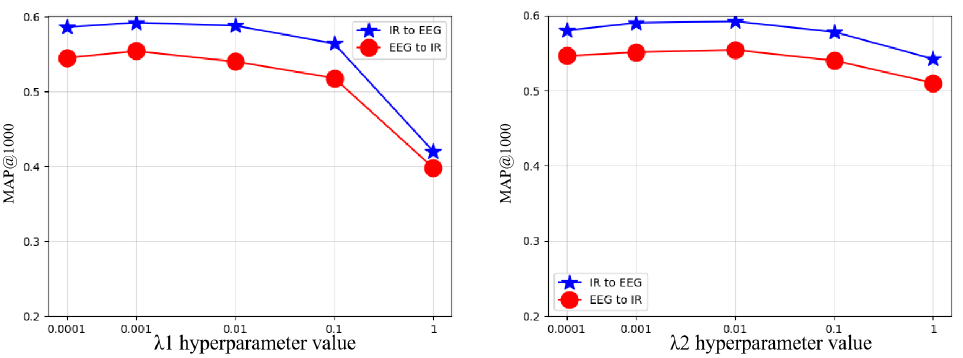
Figure 4. Sensitivity analysis of the proposed CCHR. Cross-modal (IR video and EEG) retrieval performance in terms of MAP@1000 for 64 bits hash codes when varying hyperparameters: λ 1 and λ 2